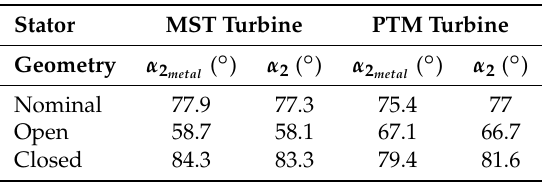
Table 1. Opening configurations for both turbines.